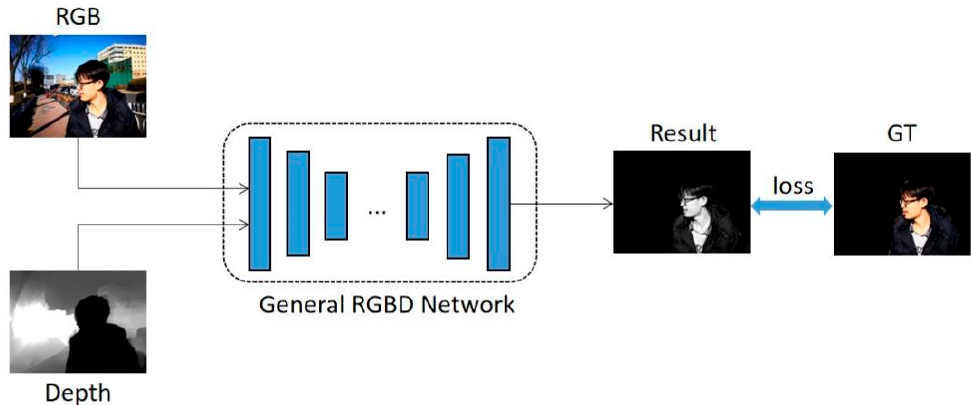
Figure 3. The neural network training process for the RGBD salient object detection, based on the specific object imaging. Following the input of the RGB map and the depth map into the general RGBD network, it is trained with the label map of the specific object imaging method, and finally the detection and imaging results containing only the target are obtained.